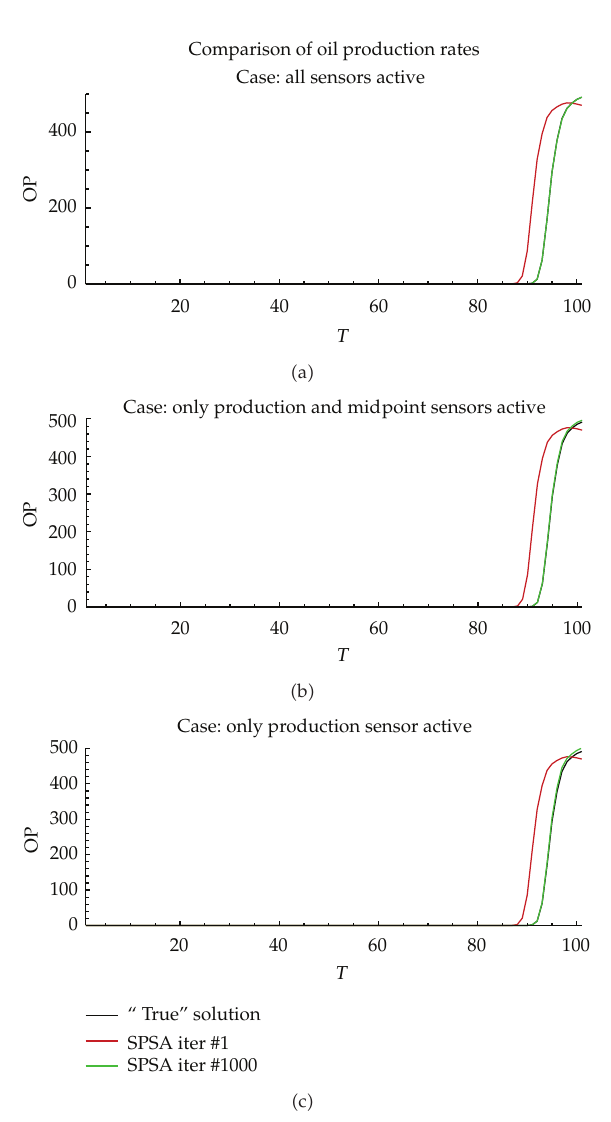
Figure 5: Example 1: history matching of well-data based on sensor